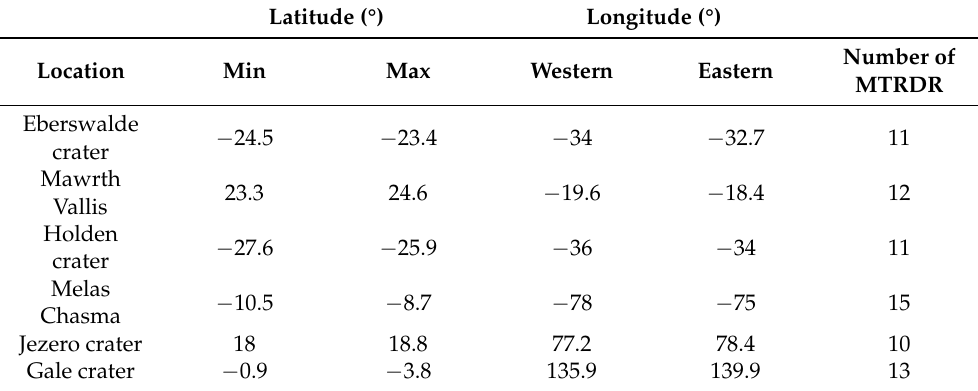
Table 1. Location names, bounding boxes and number of MTRDR found within that form the